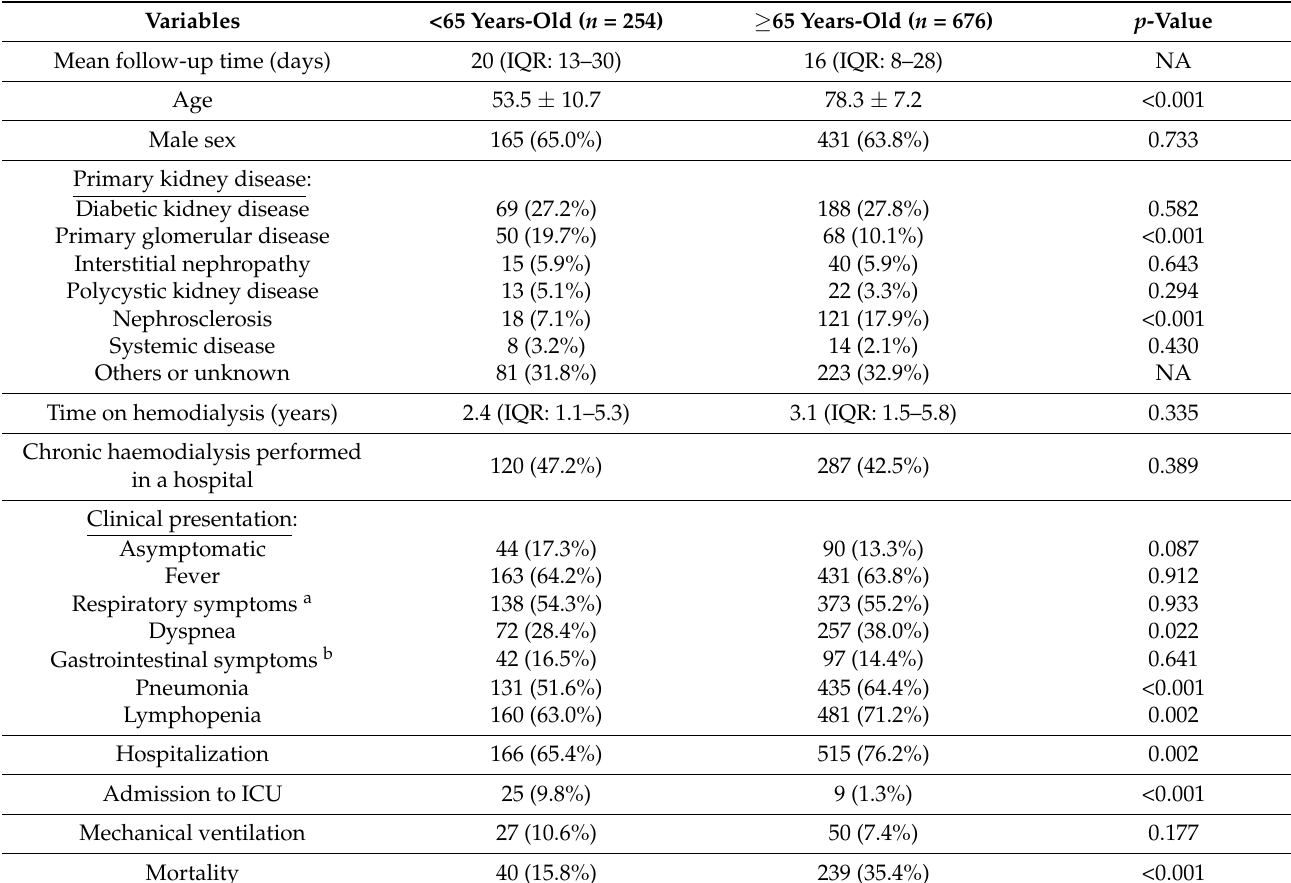
Table 1. Demographic and clinical features of elderly and non-elderly patients on haemodialysis with known outcome and follow-up time. Values expressed in mean ± SD or n (%). ICU: Intensive Care Unit. NA: Not